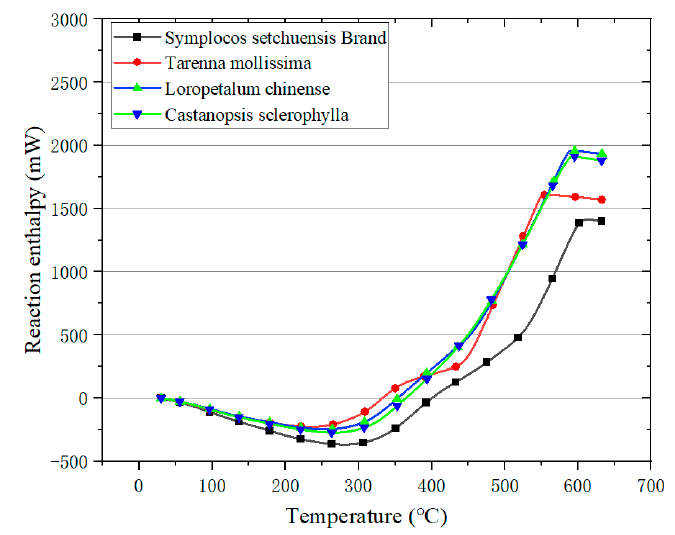
Figure 5. Results of reaction enthalpy during thermal decomposition.